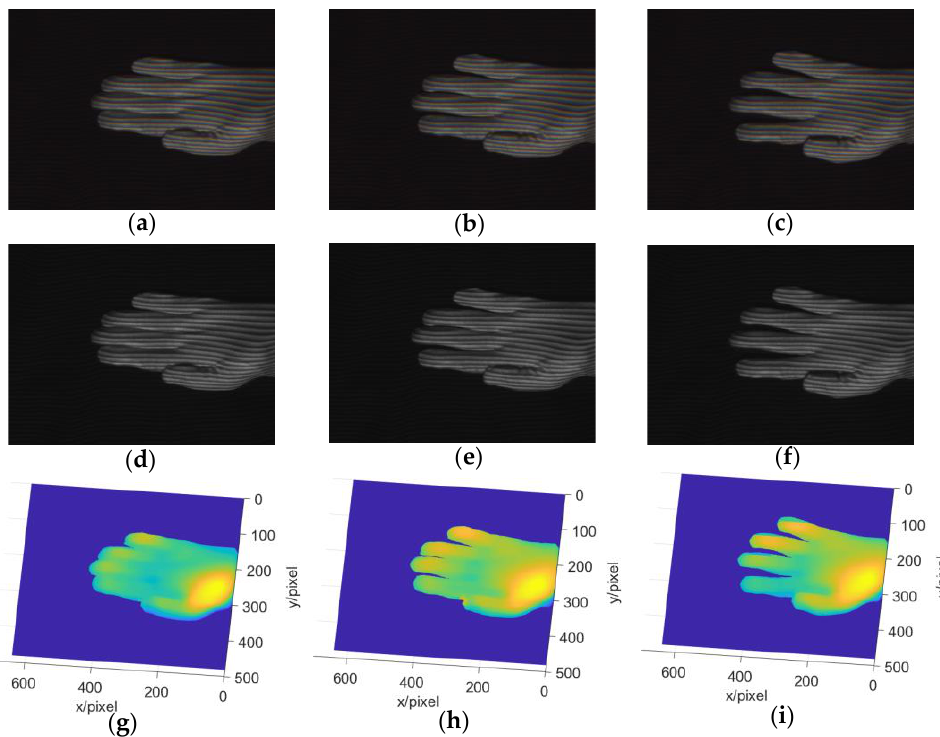
Figure 9. Reconstructed results of real-time measuring at different states: ( a – c ) the deformed patterns in States A–C from the recorded video; ( d – f ) the deformed patterns of green component after correction; and ( g – i ) the corresponding reconstructed results of the gloved hand.